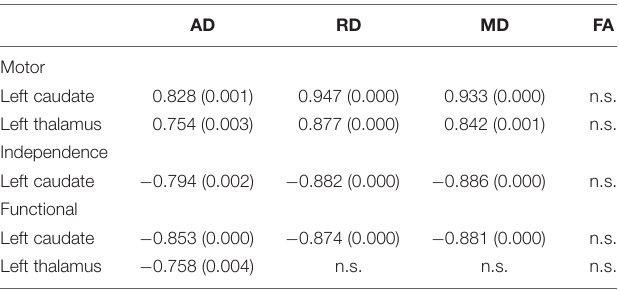
TABLE 3 | Significant correlations between tensor-derived indices in subcortical brain regions and clinical scores in patients with HD. AD RD MD